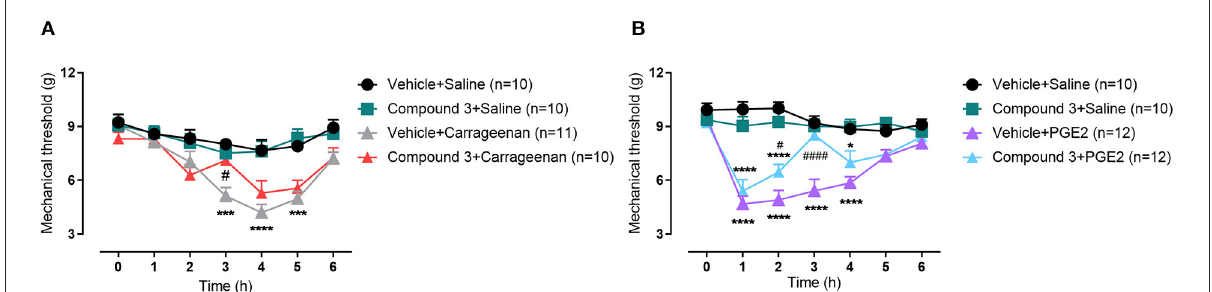
FIGURE4 Time course of paw withdrawal threshold (g) induced by (A) carrageenan (200 µ g/20 µ L) or (B) PGE 2 (1 nmol/10 µ L) injected in the hindpaw, after pre-treatment with a double dose of vehicle or cpd3 (11 mg/kg, p.o.). * p < 0.05; *** p < 0.001; **** p < 0.0001 compared to vehicle + saline group. # p < 0.05; #### p < 0.0001 compared to vehicle + carrageenan or vehicle + PGE 2 group. Two-way ANOVA followed by Bonferroni post hoc